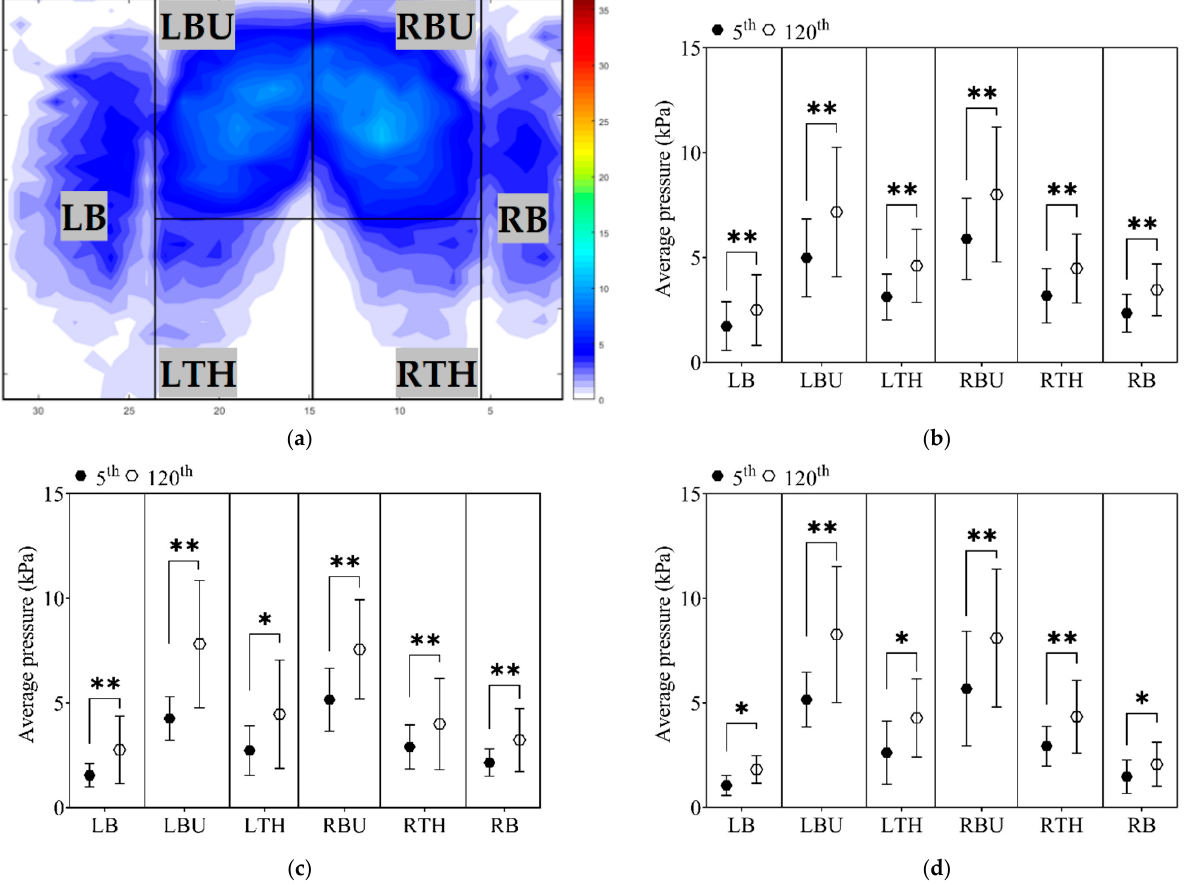
Figure 4. Applied average interface pressure by cluster groups with indicated statistical difference. ( a ) Definition of the lower limbs zones; ( b ) Cluster 1 group; ( c ) Cluster 2 group; ( d ) Cluster 3 group. Note. C1—Cluster 1; C2—Cluster 2; C3— Cluster 3; 5th minute of driving; 120th minute of driving; Statistically significant difference is indicated as * ( p < 0.05) and ** ( p < 0.001).